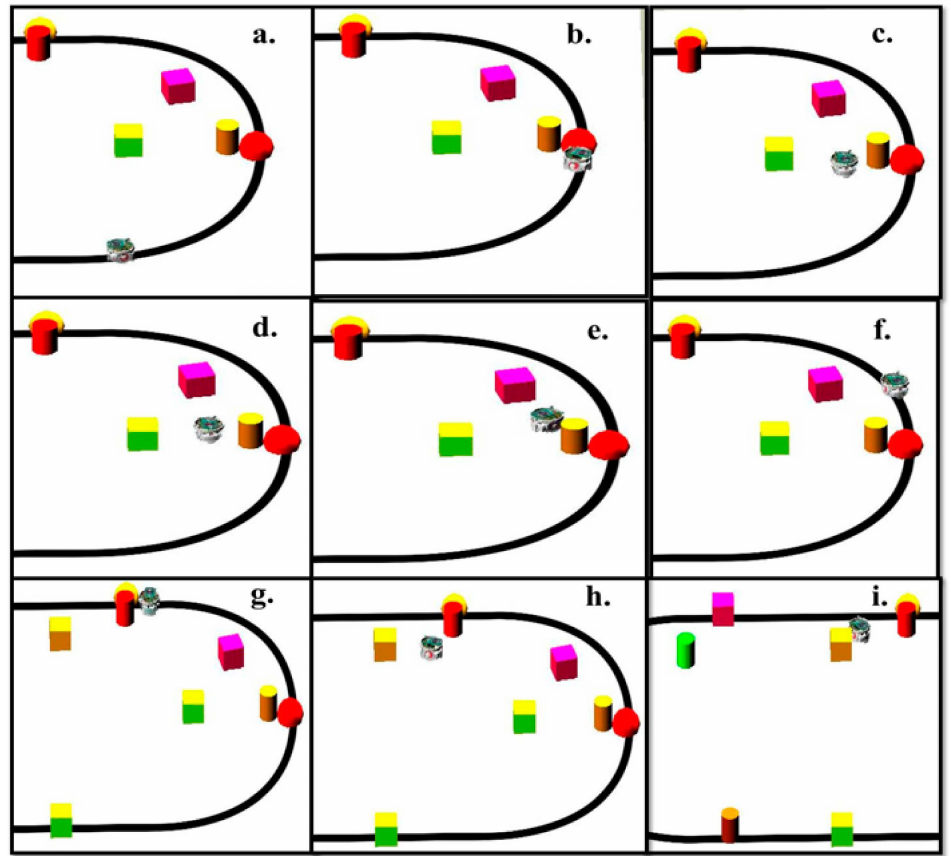
Figure 18. Simulation snapshots at various times. ( a ) The beginning of the simualtion; ( b ) The robot detects an obstacle and turns left; ( c ) The robot moves around the obstacle; ( d ) The robot between multiple scattered obstacles; ( e ) The robot turns right to avoid possible collision; ( f ) The robot returns to the line; ( g ) The robot detects another obstacle on its way; ( h ) The robot avoids obstacles; ( i ) The robot has successfully avoided